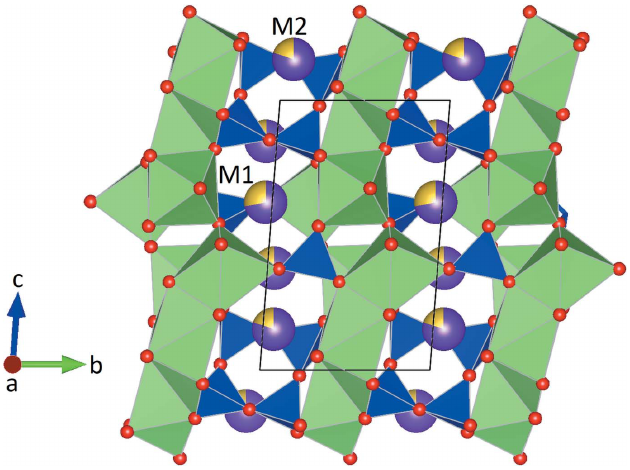
Figure 5 Projection of the crystal structure along [100]. The structure comprises insular as well as cyclic silicate anions (plotted in blue). Corner-, edge- and face-connected [CaO 6 ] octahedra are painted green. Potassium (violet) and sodium (yellow) cations occupy voids between the [SiO 4 ] and [CaO 6 ] polyhedra. Bi-colored spheres indicate the mixed K–Na positions ( M 1 and M 2). The sizes of the bi-colored segments refer to the percentages determined from the site-occupancy